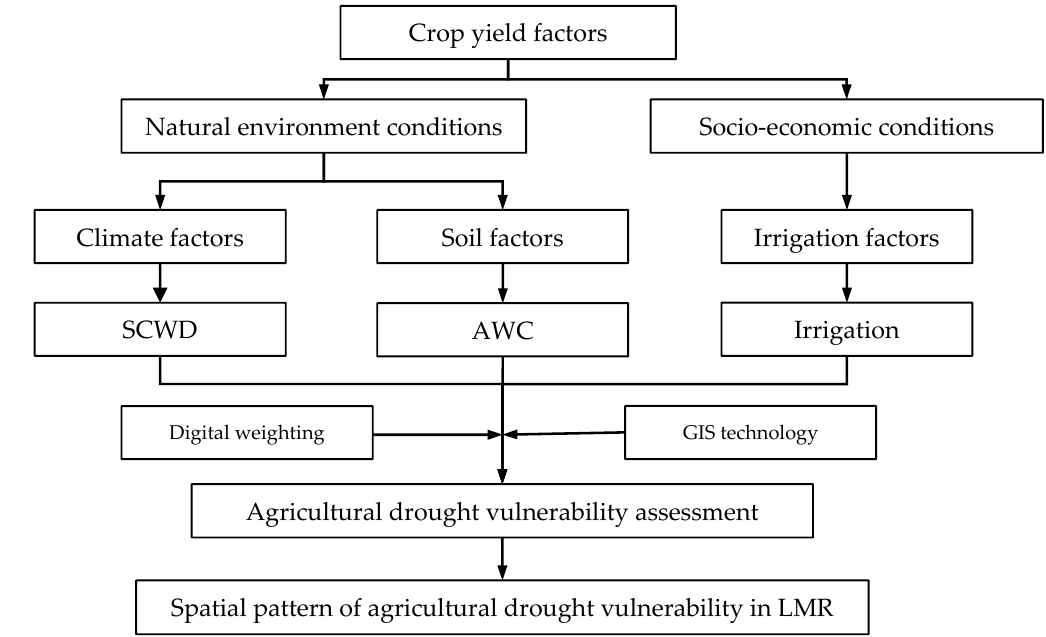
Figure 7. Agricultural drought vulnerability assessment process.